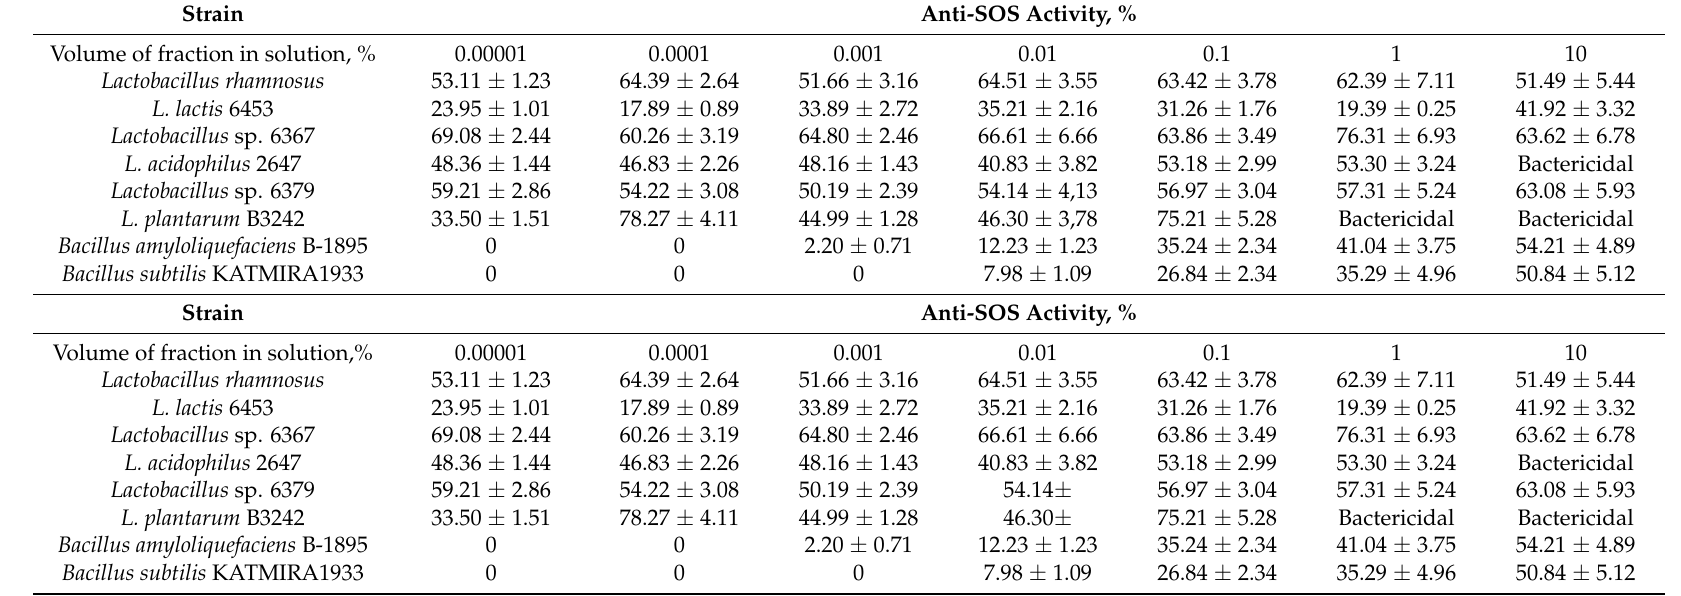
Table 1. Protective effects of Lactobacilli fermentates on the E. coli MG1655 RecA-lux strain against